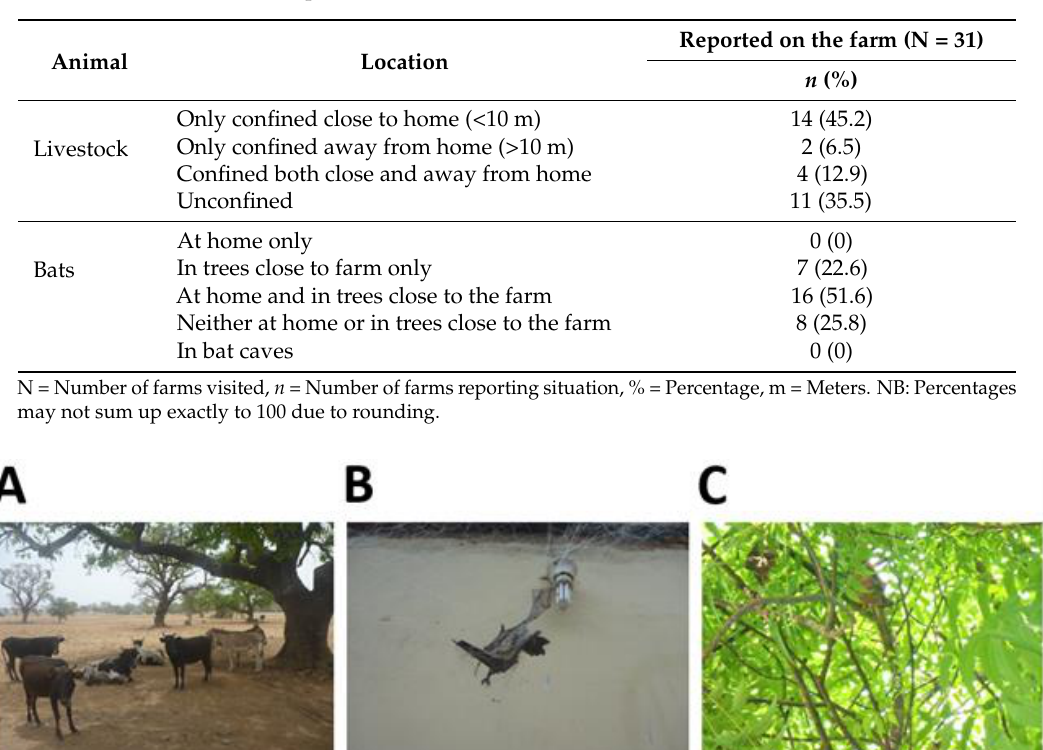
Table 2. Reported locations of livestock and bats at farms visited.